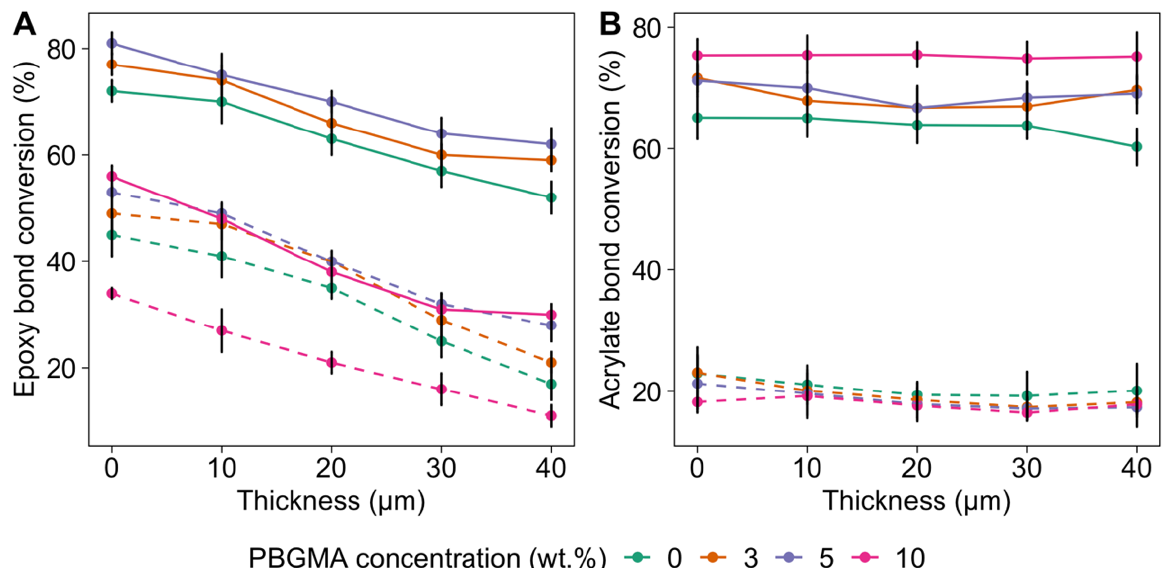
Figure 6. Conversion of ( A ) the epoxy part and ( B ) the acrylate part as a function of depth and PBGMA concentration. Raman spectra were recorded every 10 µ m of depth. The dashed lines correspond to the conversion after a first pass under UV light at 800 mW · cm − 2 , and the solid lines to the conversion after a second pass under UV light at 1200 mW · cm − 2 . The values presented are averaged from six measurements.